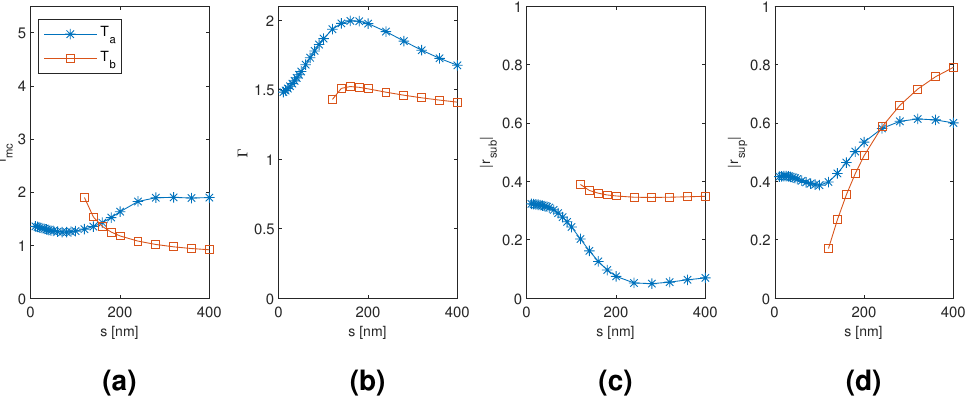
Figure 8. The results for the tetramer T a and T b mode as a function of the separation of the nanowires with the diameter of the nanowires corresponding to the point of modal cost function minimum for each mode (as listed in Table 1). ( a ) modal cost function value; ( b ) modal confinement factor; ( c ) substrate modal reflection coefficient magnitude; ( d ) superstrate modal reflection coefficient